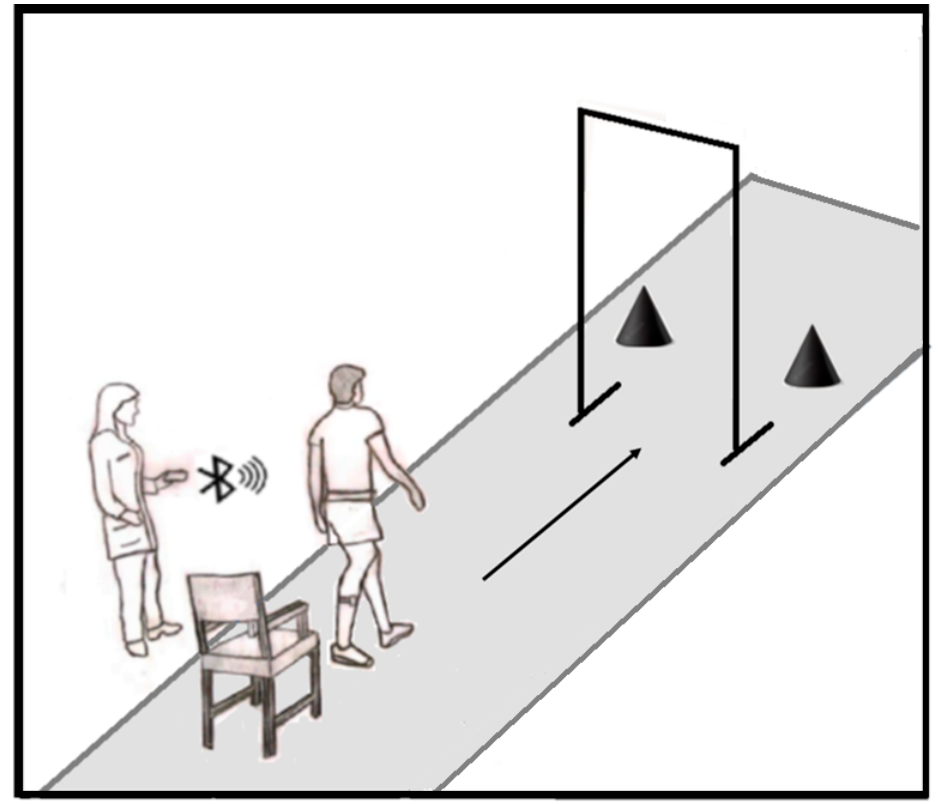
Figure 2. Representation of the simple physical motor task that causes FOG.